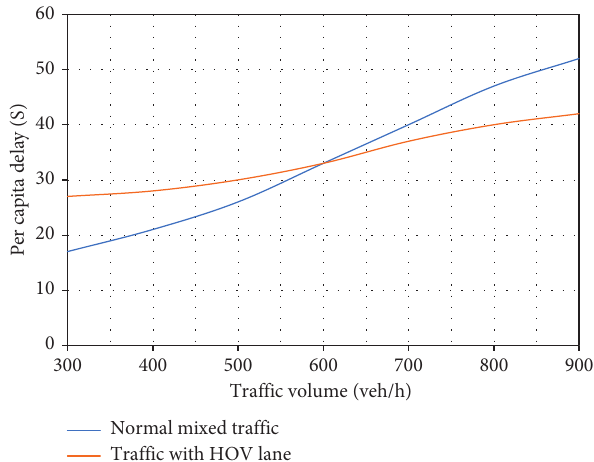
Figure 4: Per capita delay under different driving conditions at � 180 and n � q b b